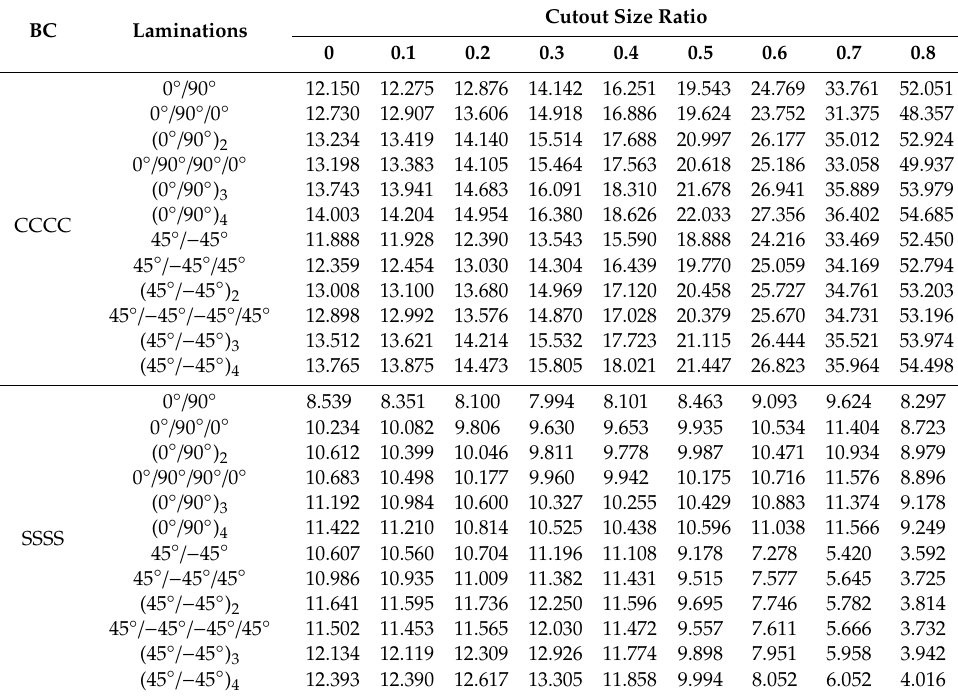
Table A1. Fundamental frequency parameters Ω of square plate with di ff erent cutout sizes under di ff erent laminations.